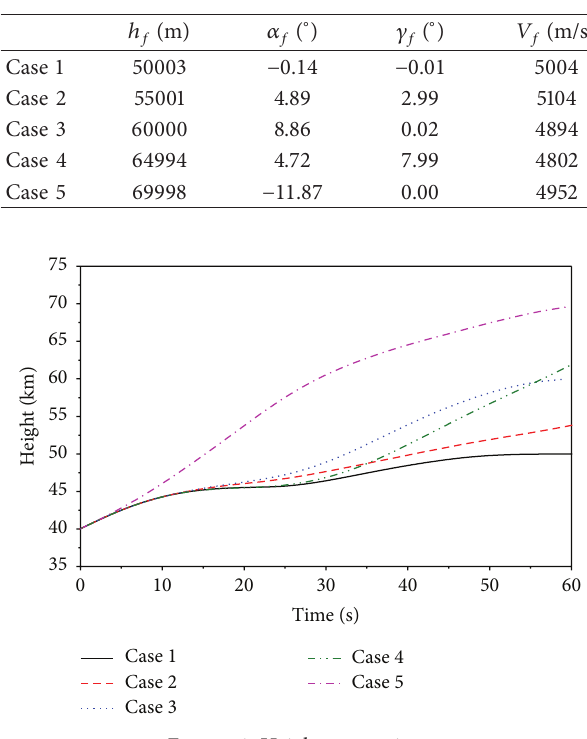
Figure 9: Height versus